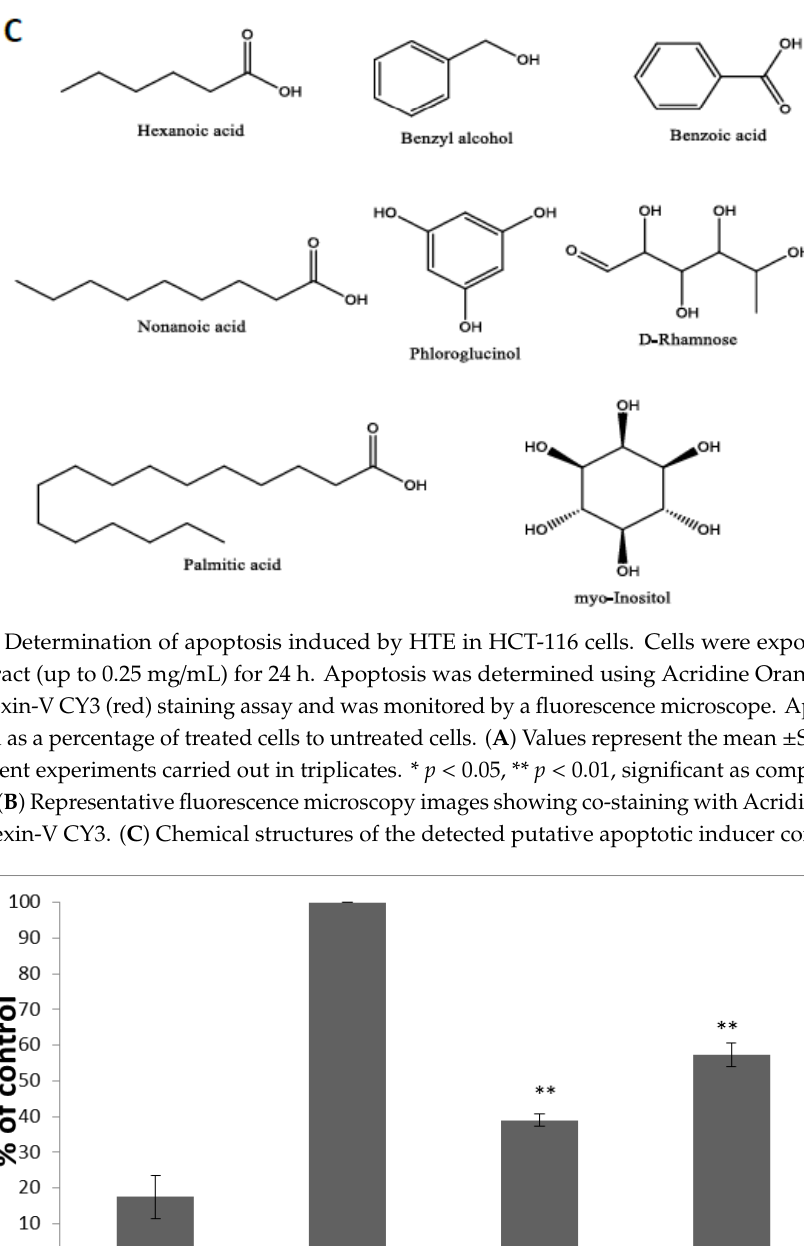
Figure 4. Analysis of intracellular caspase-3 activity in HCT-116 cells after 3 h post-treatment with staurosporine (1 µ M) and HTE. Cell lysates were combined with the caspase-3-specific substrate in a standard reaction bu ff er. Cleavage of the caspase-3-specific substrate was compared to the staurosporine (STS, 1 µ M) treated cells. The absorbance was measured at 405 nm using a microtiterplate reader. Values represent the mean ± SD of three independent experiments carried out in triplicates. ** p < 0.01—significant as compared with